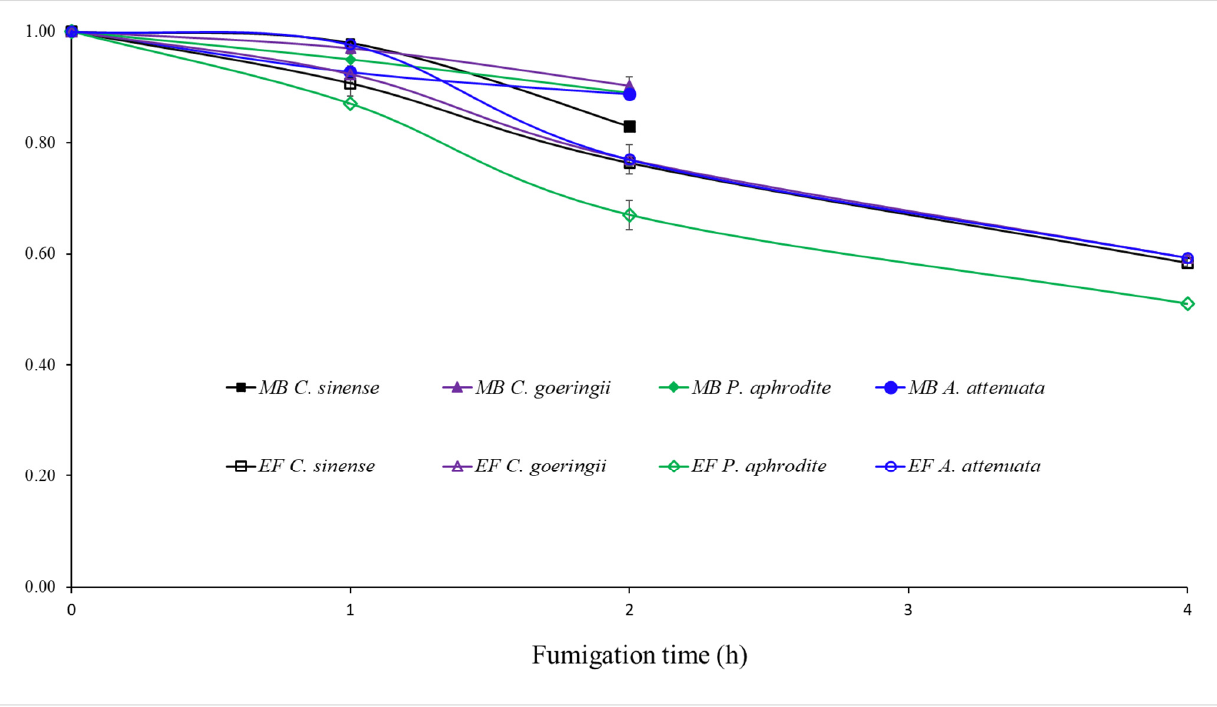
Figure 1. Comparative sorption of ethyl formate (EF) and methyl bromide (MB) in four different species of imported orchids ( C. sinense , C. goeringii , P. aphrodite and A. attenuata ) when EF and MB were applied at 35 g/m 3 for 4 h at 15 ± 1 °C and 48 g/m 3 for 2 h at 15 ± 1 °C, respectively, with a 5% loading ratio ( w / v ).